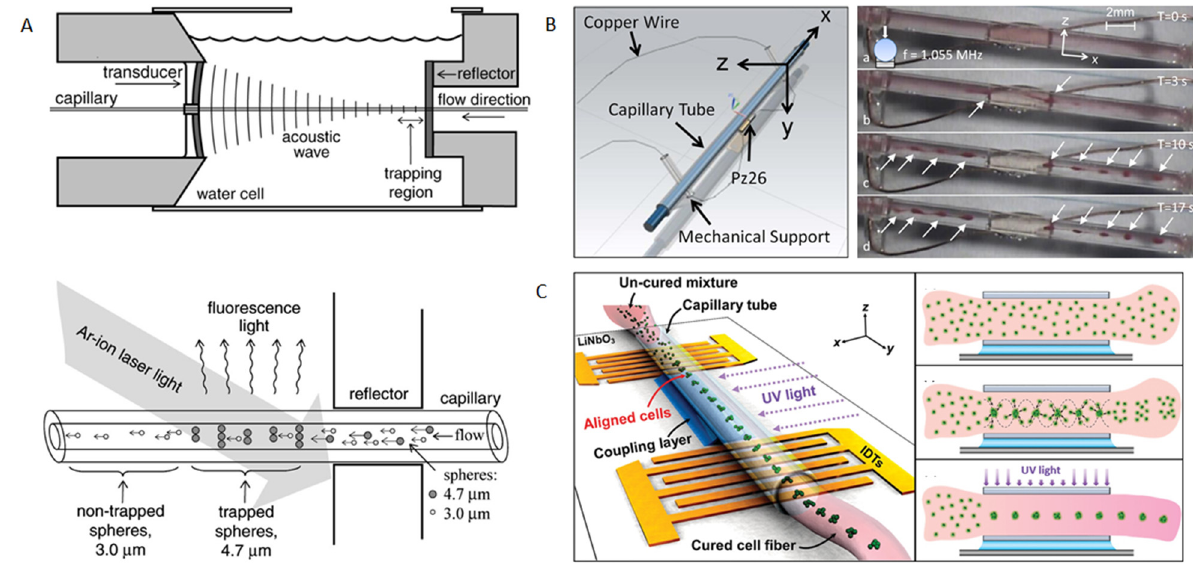
Figure 13. Acoustic trapping of microparticles in circular cross-section glass capillaries. ( A ) Trapping in a circular glass capillary ( 𝑑 = 0.075 mm) using a focusing transducer. The 4.7 µ m particles were trapped along the channel from a mixture of 4.7 and 3 µ m particles. Reprinted with permission from [80] . ( B ) Trapping in a circular glass capillary ( 𝑑 = 0.85 mm) using a single PZT. The times indicate how long the microparticles were trapped into clusters along the fluid channel. Reprinted with permission from [82] . ( C ) Trapping in a circular glass capillary ( 𝑑 = 0.1 mm) using SAWs. Beads and Hela cells were trapped within a viscous polymer solution, which could then be polymerized and extracted within a polyethylene tube. Reprinted with permission from [83] .